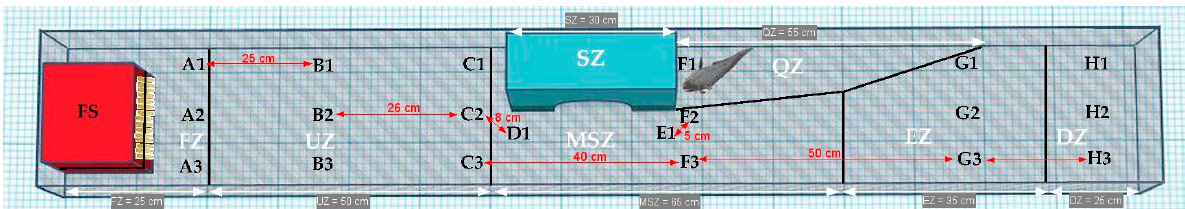
Figure 1. Schematic of the experimental channel showing monitored zones (white letters) FZ = feeding zone where FS = feeding station was situated, UZ = upstream zone, MSZ = mid-stream zone, SZ = shelter zone, QZ = quiet zone, DZ = downstream zone, and EZ = escape zone; points for flow velocity measurement (black numbers A1–H3). Zones are delineated by black lines. Distance between points for flow velocity measurement is noted by red color and distance between monitored zones is marked with white letters on grey background.